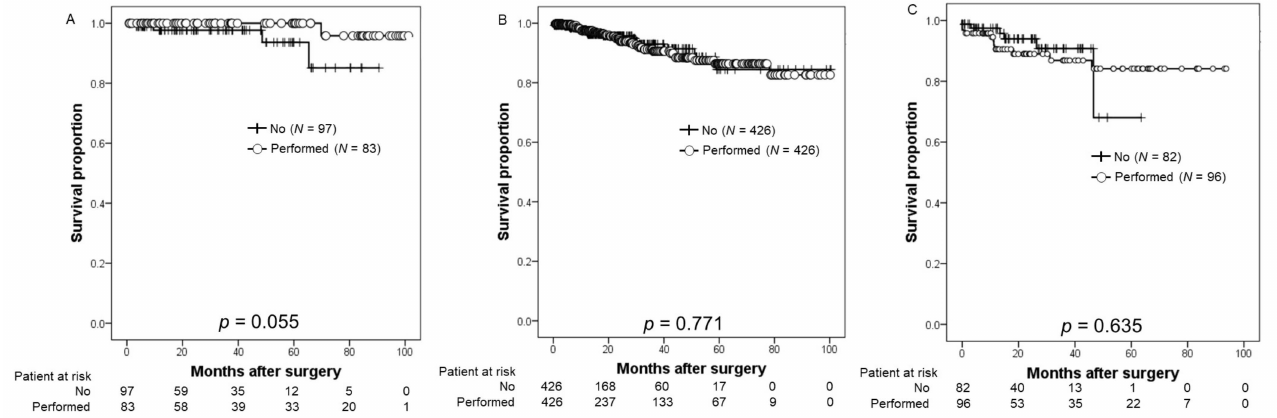
Figure 3. Kaplan–Meier estimates of biochemical recurrence-free survival (BRFS) according to the initial PSA levels stratified by the National Comprehensive Cancer Network risk stratification. ( A ) According to the low-risk PCa, the 2-year BRFS rate was 97.7% in patients undergoing robot- assisted radical prostatectomy (RARP) and pelvic lymph node dissection (PLND) (the non-PLND group) and 100% in those who underwent RARP with pelvic lymph node dissection (PLND) (PLND group). ( B ) Regarding the intermediate-risk PCa, the 2-year BRFS rates in the non-PLND and PLND groups were 95.7% and 94.3%, respectively. ( C ) Based on the high-risk PCa, the 2-year BRFS rate was 94.0% in the non-PLND group and 83% in the PLND